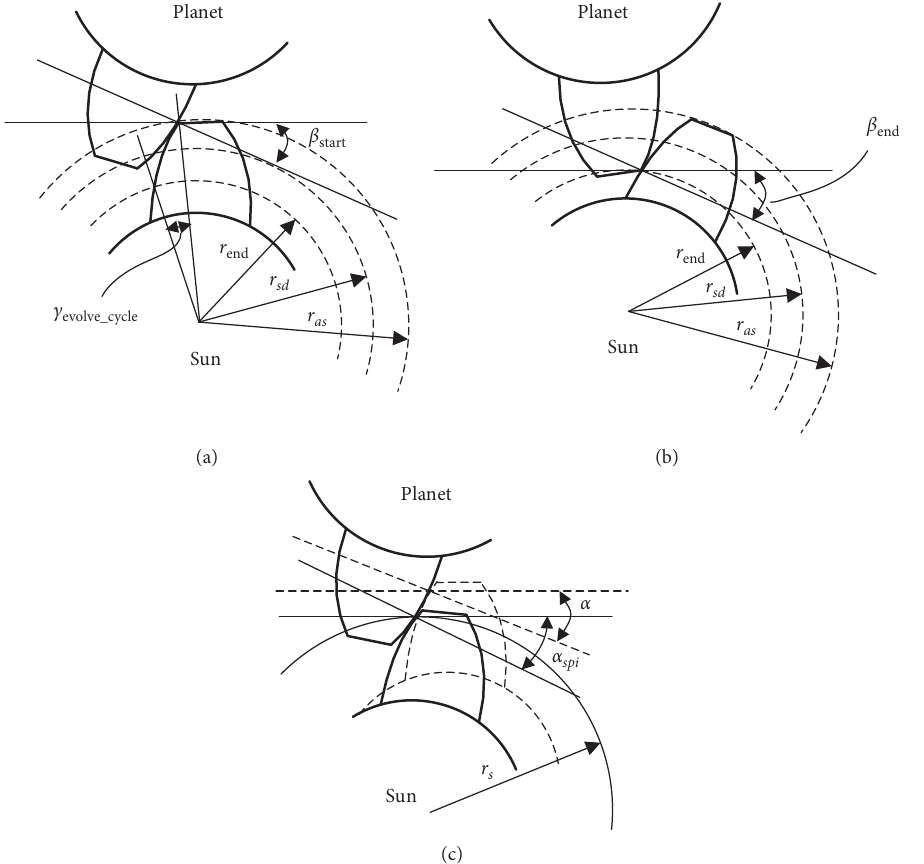
Figure 4: The meshing progress of the sun and planet gears. (a) The moment of meshing start. (b) The moment of meshing finish. (c) The meshing progress with the sun gear bounce.